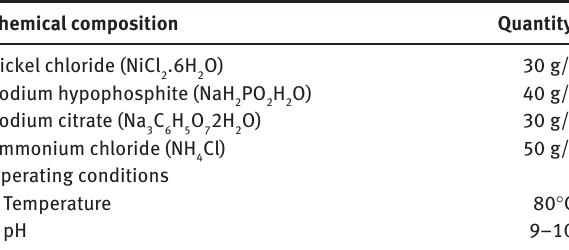
Table 1 Chemical composition of the electroless nickel plating bath and its operating